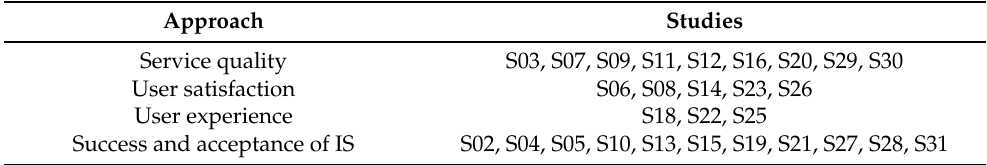
Table 7. Evaluation approaches and their respective